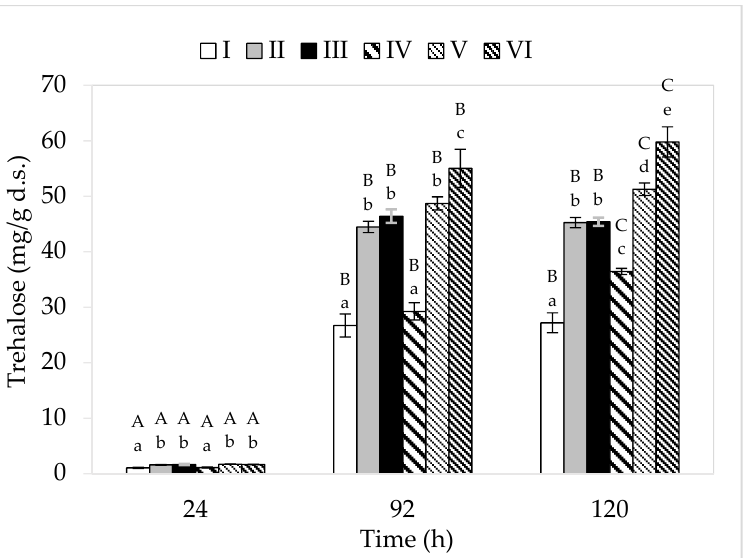
Figure 4. Accumulation of trehalose. A, B, and C—homogeneous groups of the influence of the cultivation time on the accumulation of trehalose—the Tukey’s test (a one-way analysis of variance was performed); a, b, c, d, and e—homogeneous groups of the influence of the medium on the accumulation of trehalose—the Tukey’s test (a one-way analysis of variance was performed).